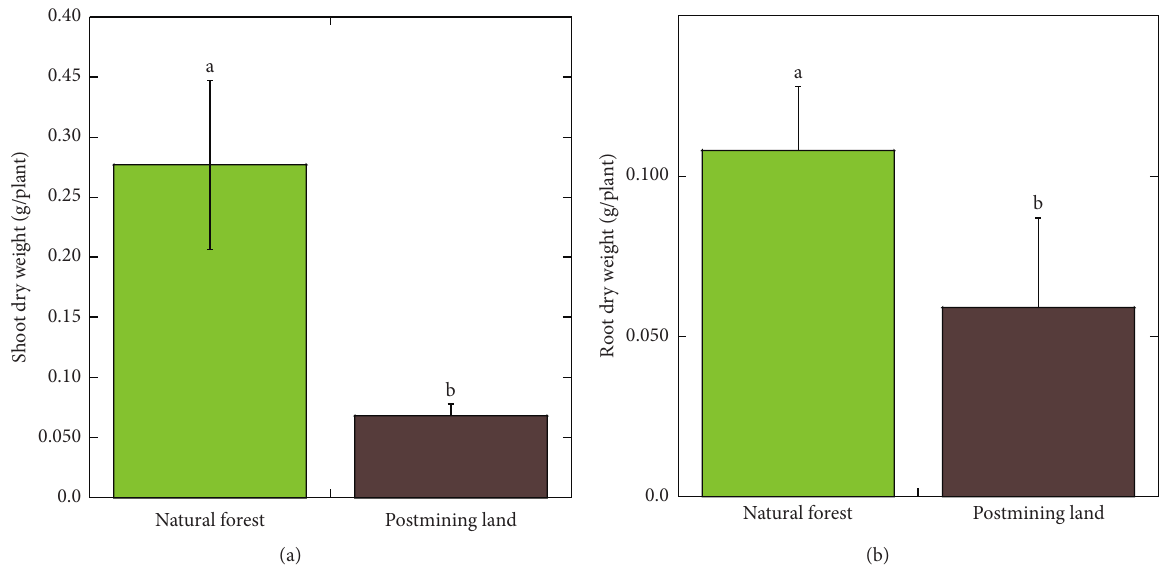
Figure 4: Shoot dry weight (a) and root dry weight (b) of Falcataria moluccana grown on natural forest soils and post bauxite mining soils for 15 weeks under greenhouse conditions. Different letters of each column chart indicate a significant difference ( P < 0 . 05) by the t test. Mean ± standard error is shown ( n �